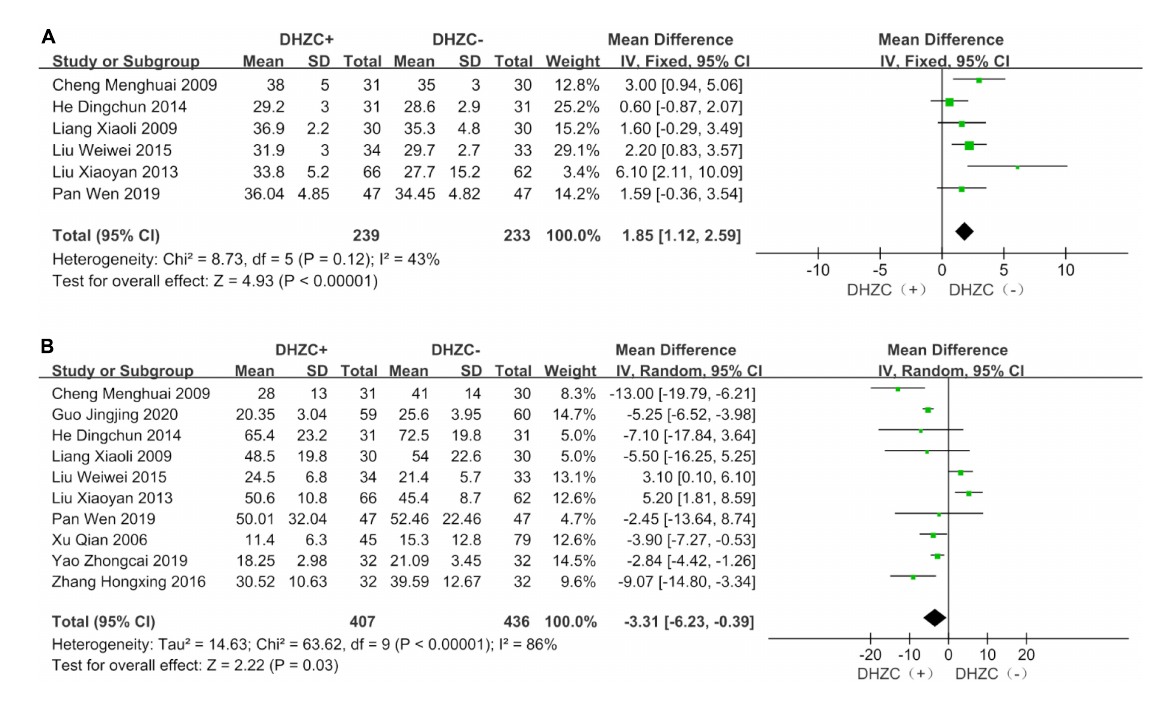
FIGURE6 The effect of Dahuang Zhechong pill (DHZCP)-based therapy on albumin (ALB) and total bilirubin (Tbil). Fixed-effects models were applied in panel (A) . Random-effects models were applied in panel (B) . (A) Total ALB; (B) Total